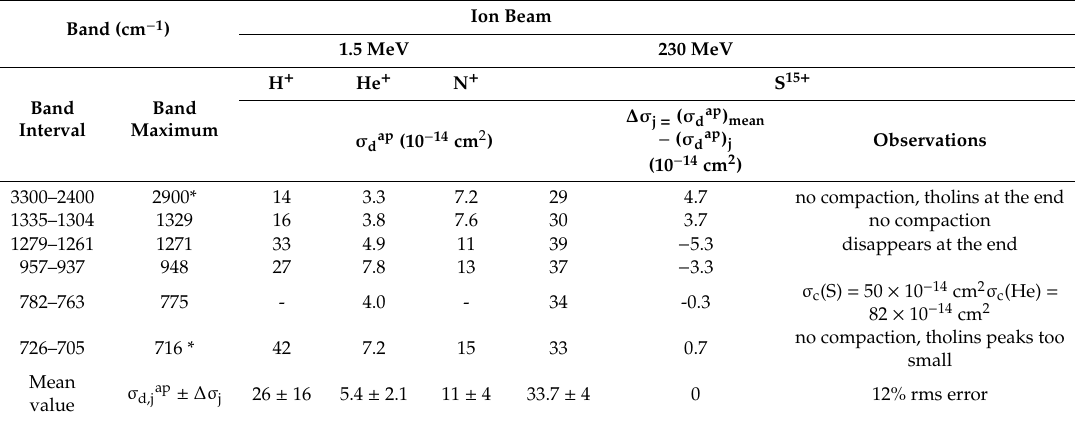
Table 3. Band interval used for the integrated absorbance calculation. Apparent destruction cross sections obtained from individual fittings for 1.5 MeV, H + , He + and N + , and 230 MeV S 15 + ion irradiations. For S 15 + , ∆ σ j is the discrepancy between the mean value and each individual σ dap . (*) Overlapping with product’s